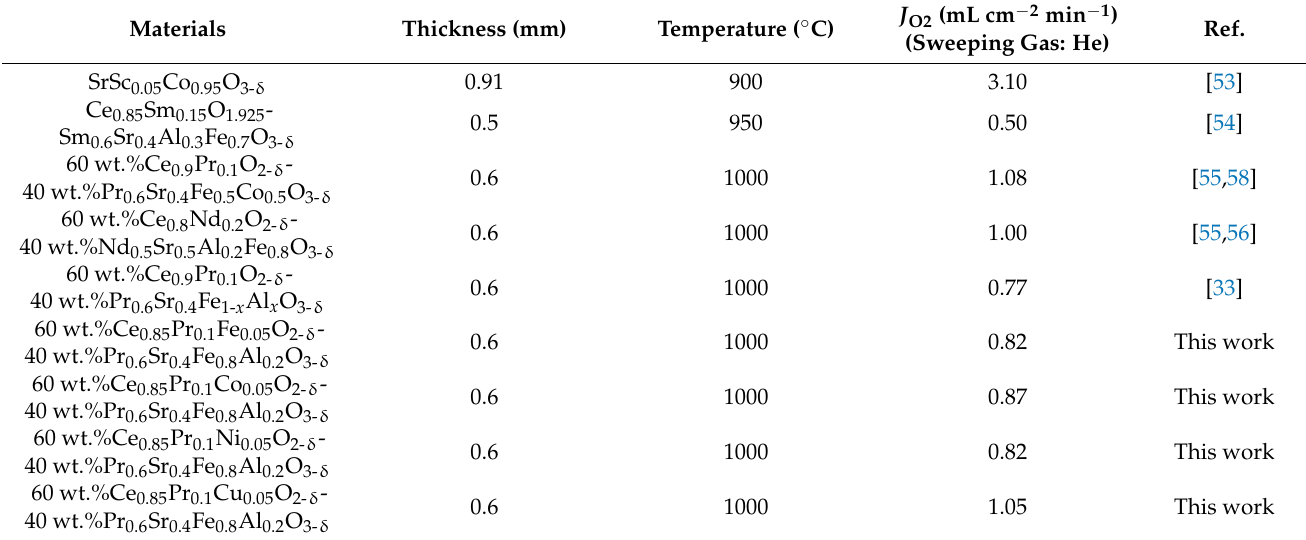
Table 2. Comparison of oxygen permeation fluxes of different oxygen permeable membranes.